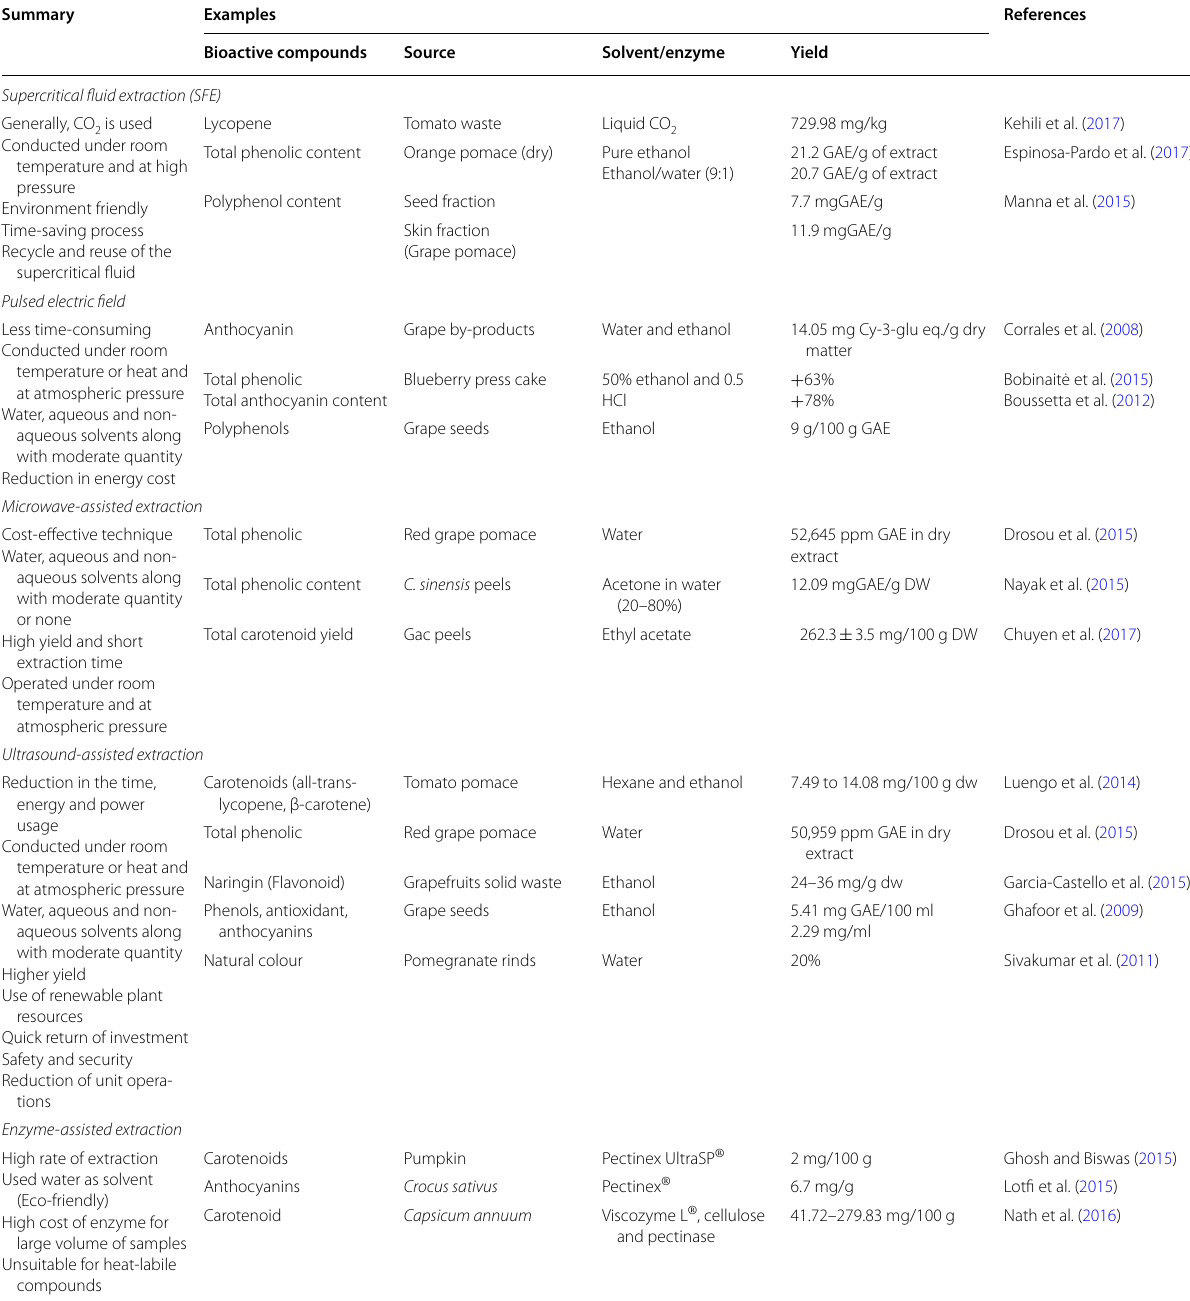
Table 2 Comparison of different green extraction techniques along with their